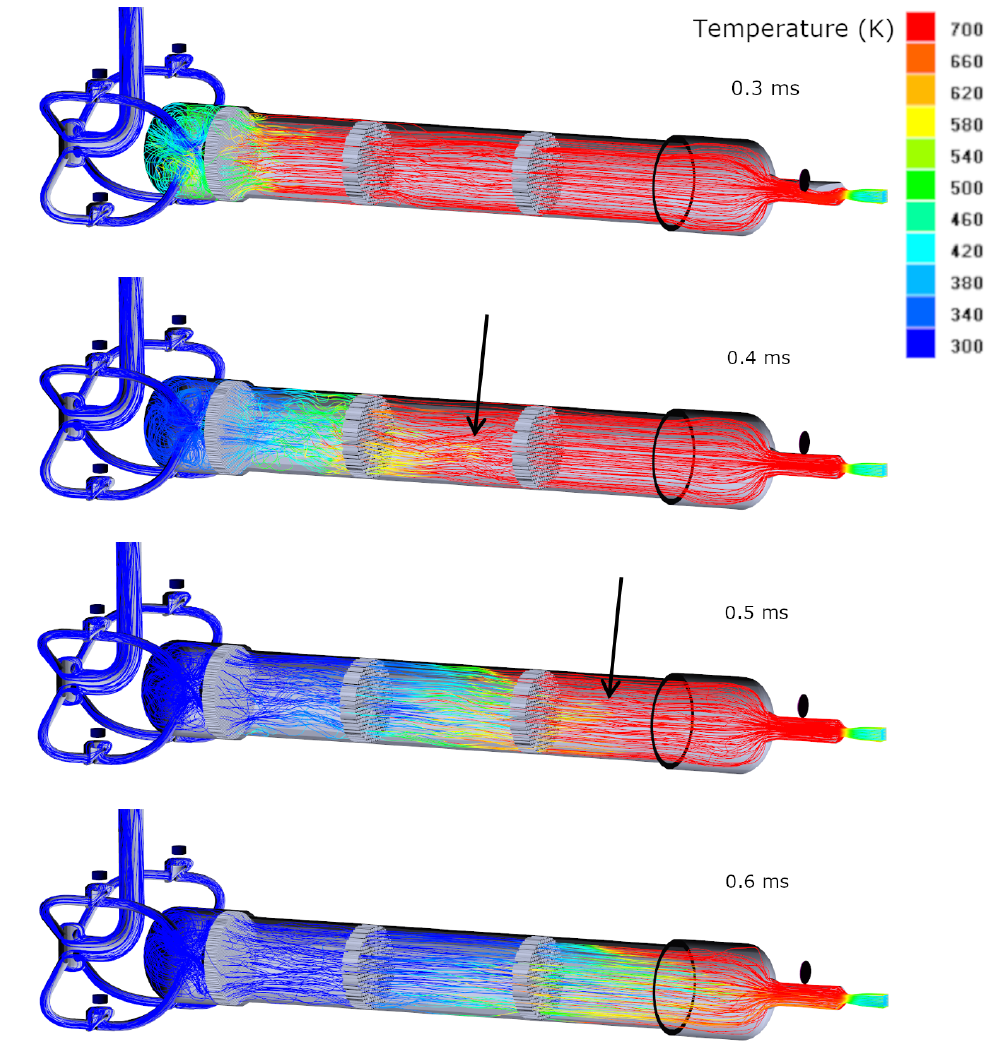
Figure 15. Full domain numerical NS simulation of time evolution of hot-cool air boundary inside plenum section.